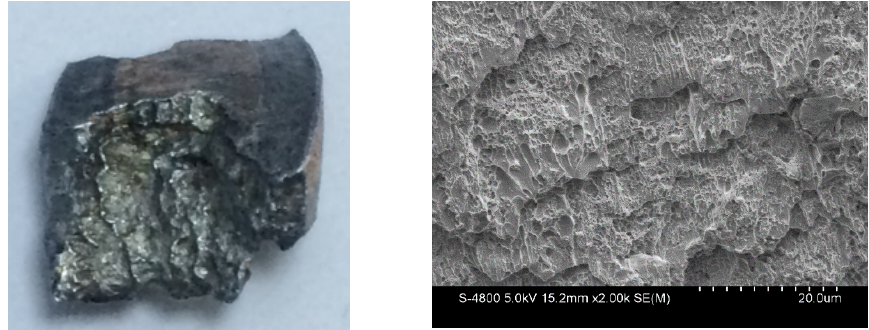
Figure 12. Typical fracture surface of fragment from Specimen 2# (left) and its morphology captured by SEM (right).